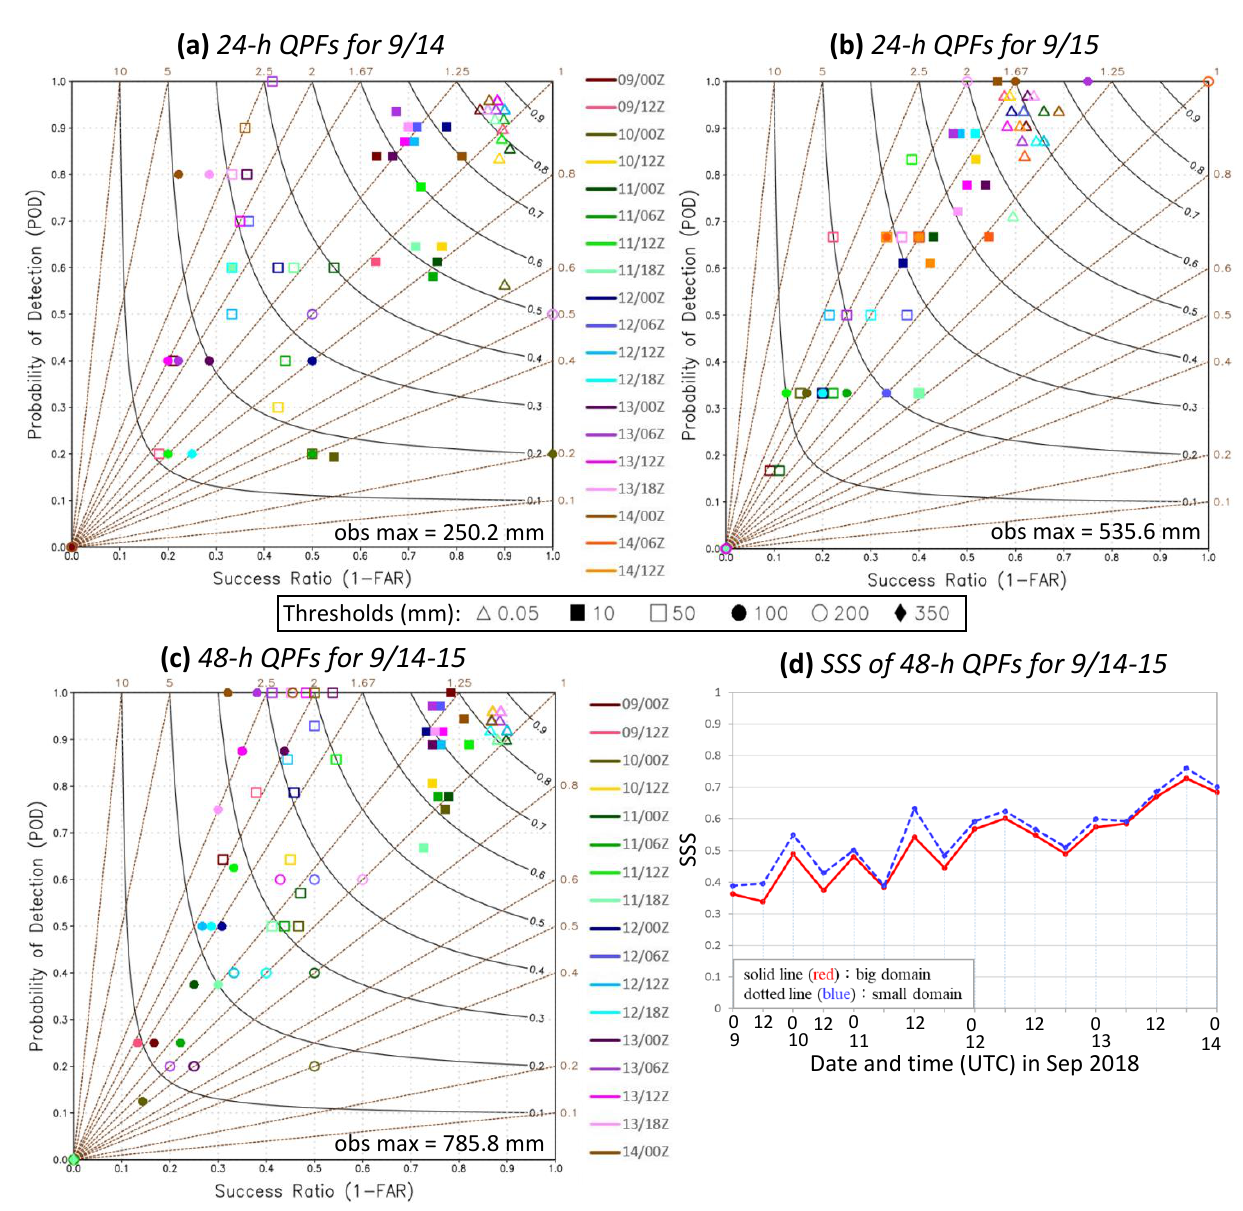
Figure 5. Performance diagrams of 24 h QPFs by forecasts at different initial times (color) targeted for ( a ) 14 and ( b ) 15 September, and of ( c ) 48 h QPFs targeted for 14 – 15 September 2018 during Mangkhut at six selected thresholds from 0.05 to 350 mm (symbol, see insert). ( d ) The SSS values of 48 h QPFs for 14 – 15 September as functions of initial time for the big (entire Philippines) and small (Luzon island only) domains. Note that only two runs were executed per day (at 0000 and 1200 UTC) from 9 – 10 September.